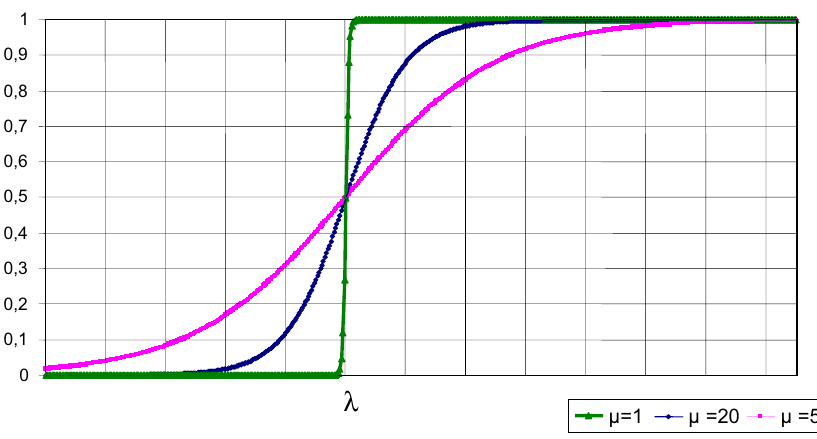
Fig. 2. Impact of indicator m on dependency